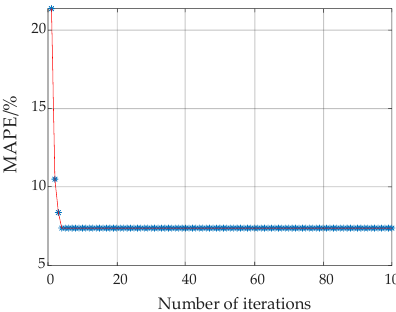
Figure 10. Variation of mean absolute percent error (MAPE) with number of iterations based on the PSO algorithm at 1.398T.